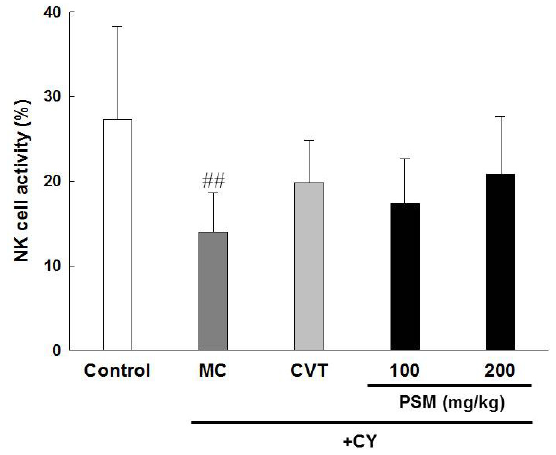
Figure 3. The effects of PSM on NK cell-mediated tumour cell cytotoxicity in CY-treated immunosuppressed mice. Model control (MC): CY-treated immunosuppressed mice. CVT: CVT-E200™ (200 mg/kg) was used as a positive control. The data are expressed as the mean ± SD ( n = 10). ## p < 0.01 vs. vehicle-treated control